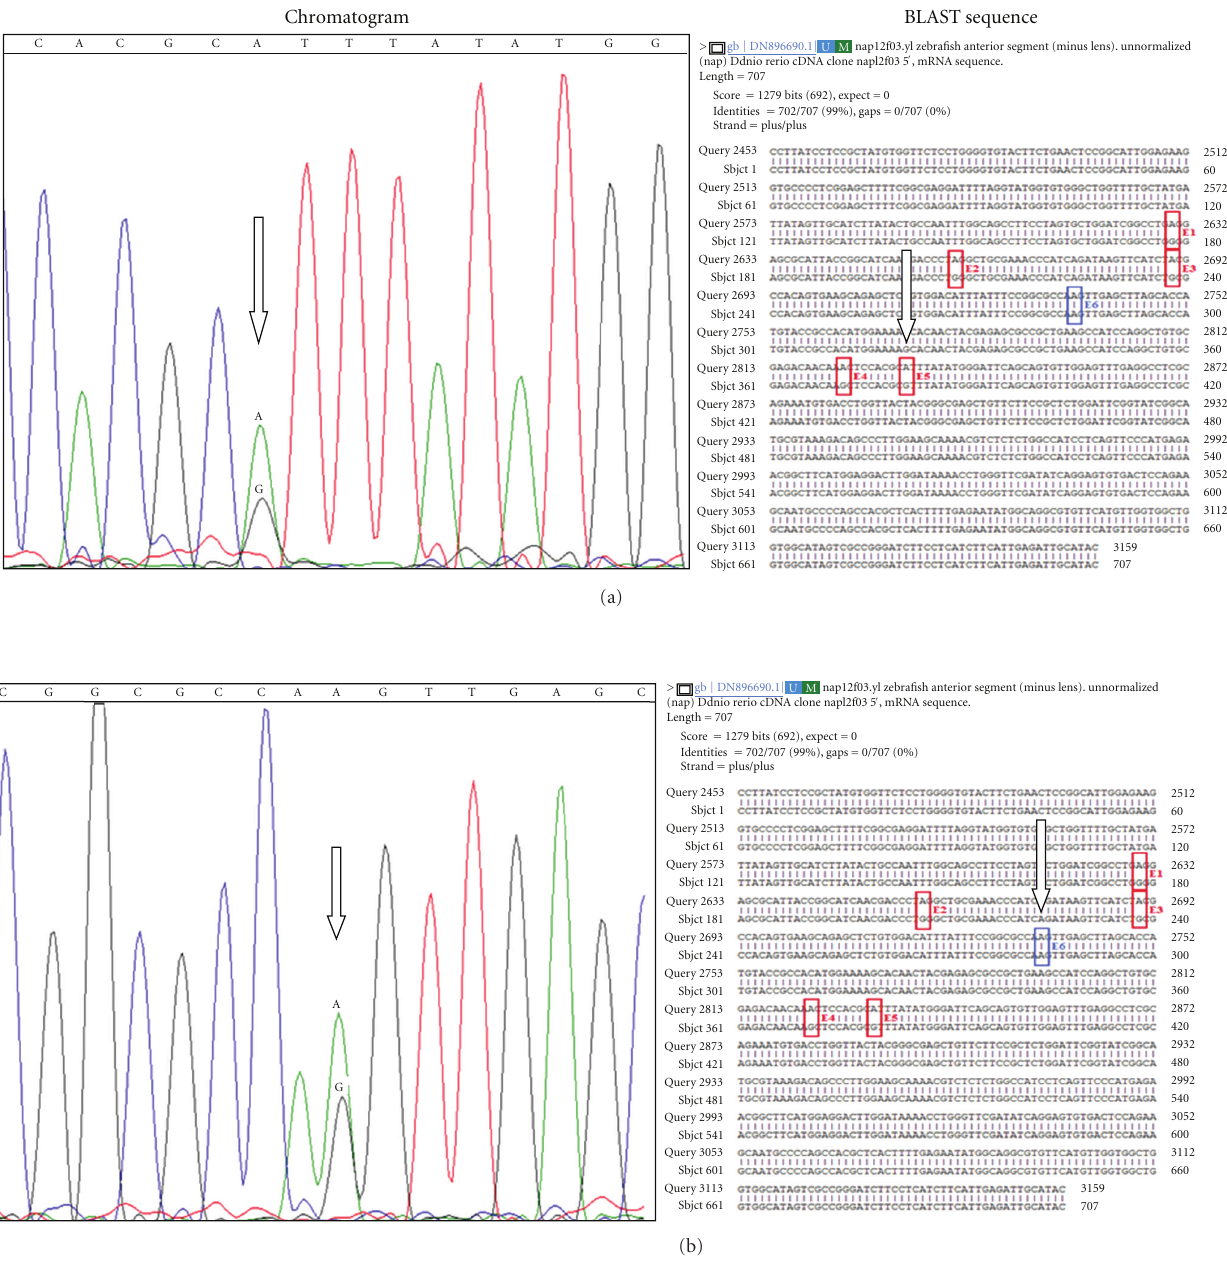
Figure 4: Sequencing results; E5, E6. Chromatogram sequence analysis of the RT-PCR product obtained using the F3/R3 primer pairs. The sequences show double peaks representing A/G mixed signals corresponding to position E5 ((a) open black arrow) and to a new position, E6 ((b) open black arrow and outlined in blue), in the BLAST